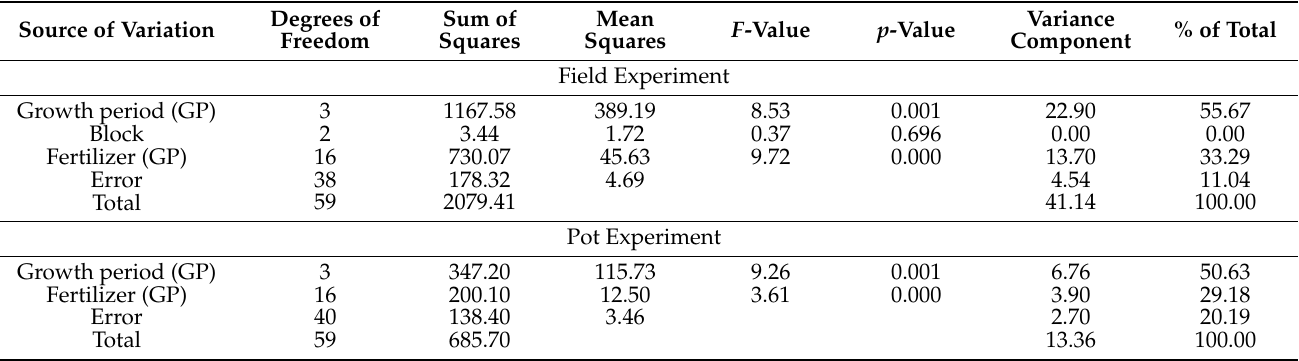
Table 5. An estimate of variance due to growth periods and fertilizer treatments on cryptolepine yield in the field and pot